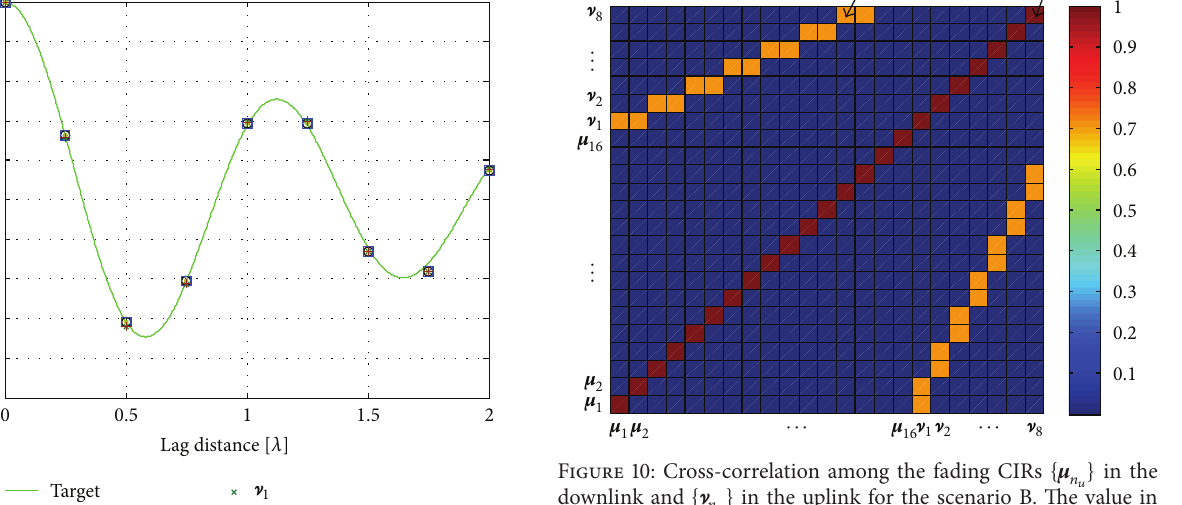
Figure 10: Cross-correlation among the fading CIRs { 𝜇 𝑛 } in the uplink for the scenario B. The value in downlink and { ^ 𝑛 𝑢 the correlation matrix denotes the correlation between two fading CIRs indicated in the 𝑥 - and 𝑦